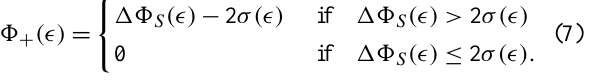
((cid:15)) as the no-rain noise level, (cid:49)(cid:56) S Defining 2 σ PRN no-rain